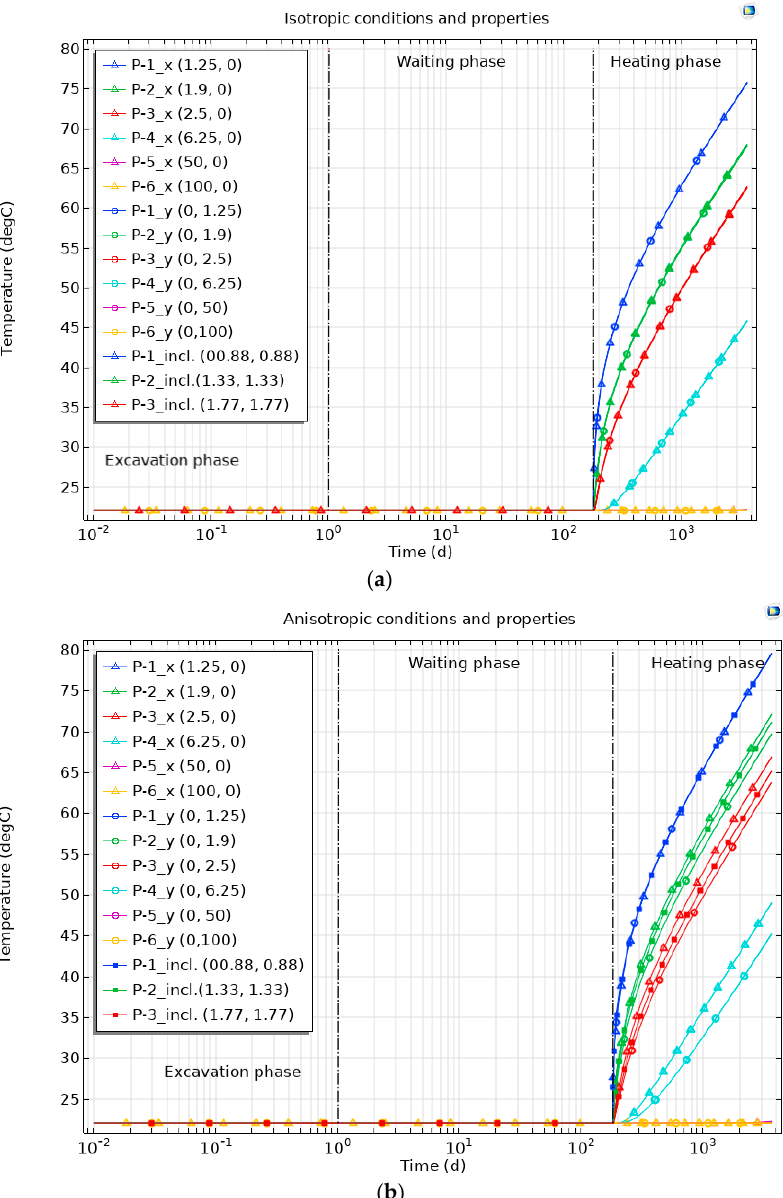
Figure 4. DC variant: evolution of the temperature at points P-1 - P-6 in horizontal and vertical directions for comparison: ( a ) isotropic stress conditions and isotropic properties, ( b ) anisotropic stress conditions and anisotropic properties. Included are also the results at 3 auxiliary points located at 45 degrees from the horizontal axis. The observation point label includes point coordinates (x, y) in meters in the model domain.